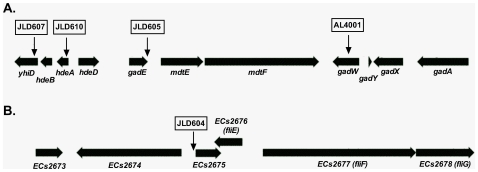
A) Acid fitness island of E. coli. The transposon insertion in E. coli K-12, AL4001, is within gadW at nucleotide 3662317 of Genbank accession number U00096. The transposon insertions in the EHEC strains are shown on the same map but the nucleotide positions are from Genbank accession number BA000007. JLD605 is within gadE at nucleotide 4401036; JLD607 is within yhiD at nucleotide 4397949; JLD610 is within hdeA at nucleotide 4398821. B) JLD604 is just upstream of ECs2675 in the anti-sense orientation at nucleotide 3662317.